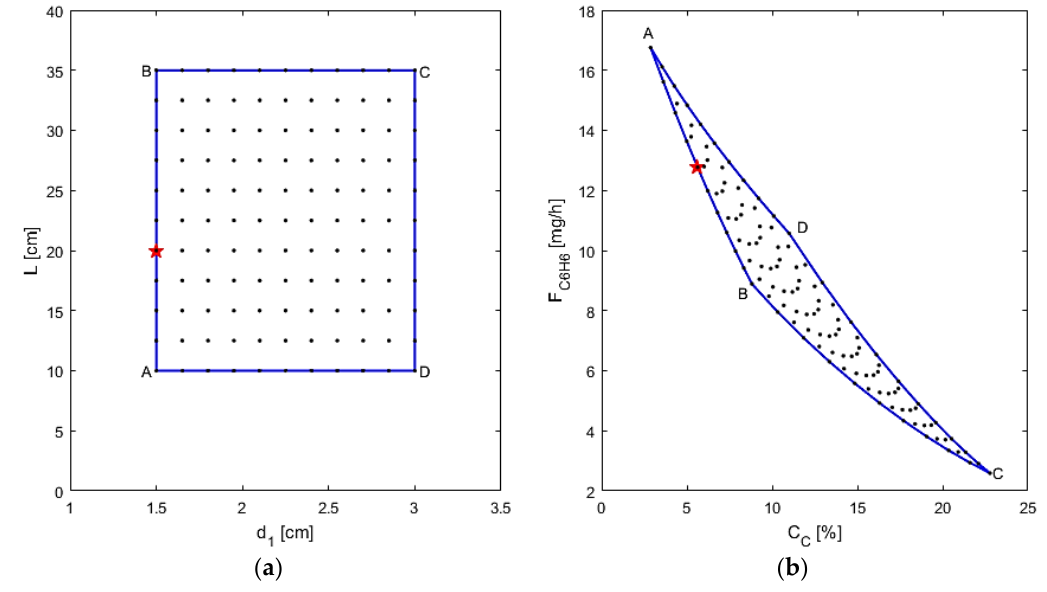
Figure 9. ( a ) AIS—reactor dimensions; ( b ) AOS—C C and F C6H6 .